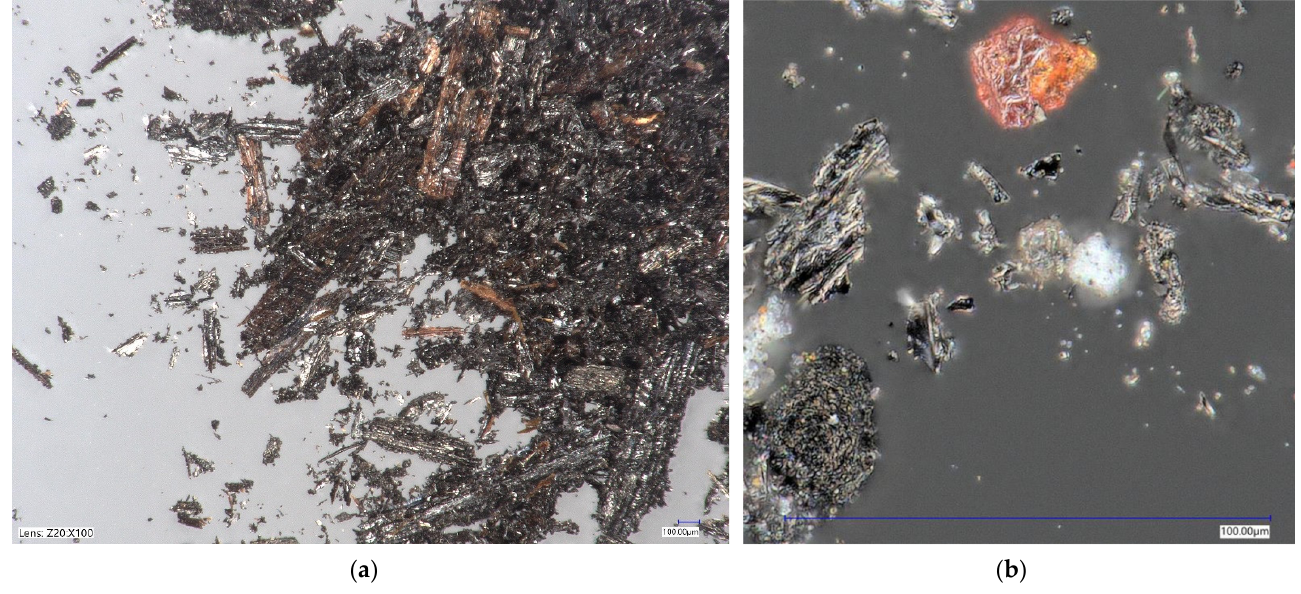
Figure 2. Optical microscope view of biochar: ( a ) overall picture; ( b ) shape of the single grain.